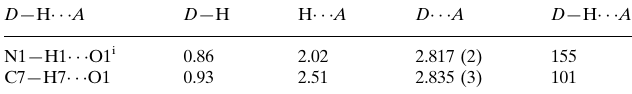
Hydrogen-bond geometry (A˚ , (cid:1)